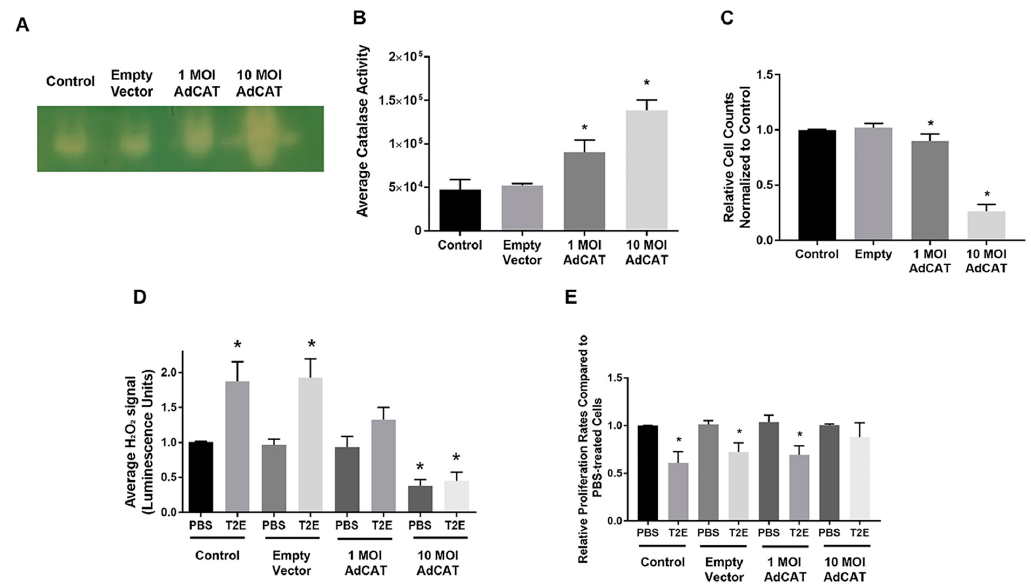
Figure 3. The effects of MnTE-2-PyP-induced intracellular H 2 O 2 increase on LNCaP cell proliferation. ( A ) A representative image of catalase activity in LNCaP cells with different MOI catalase adenovirus (CAT) / empty vector (Empty) transduction. ( B ) Densitometry analysis of ( A ). ( C ) LNCaP cell growth with adenovirus transduction after 96 h. ( D ) Measurement of cellular H 2 O 2 levels and ( E ) cell growth of LNCaP cells with 50 MOI catalase adenovirus / empty vector transduced after 96 h treatment of PBS or MnTE-2-PyP. All data represent mean ± SD from at least three independent experiments. * p < 0.05